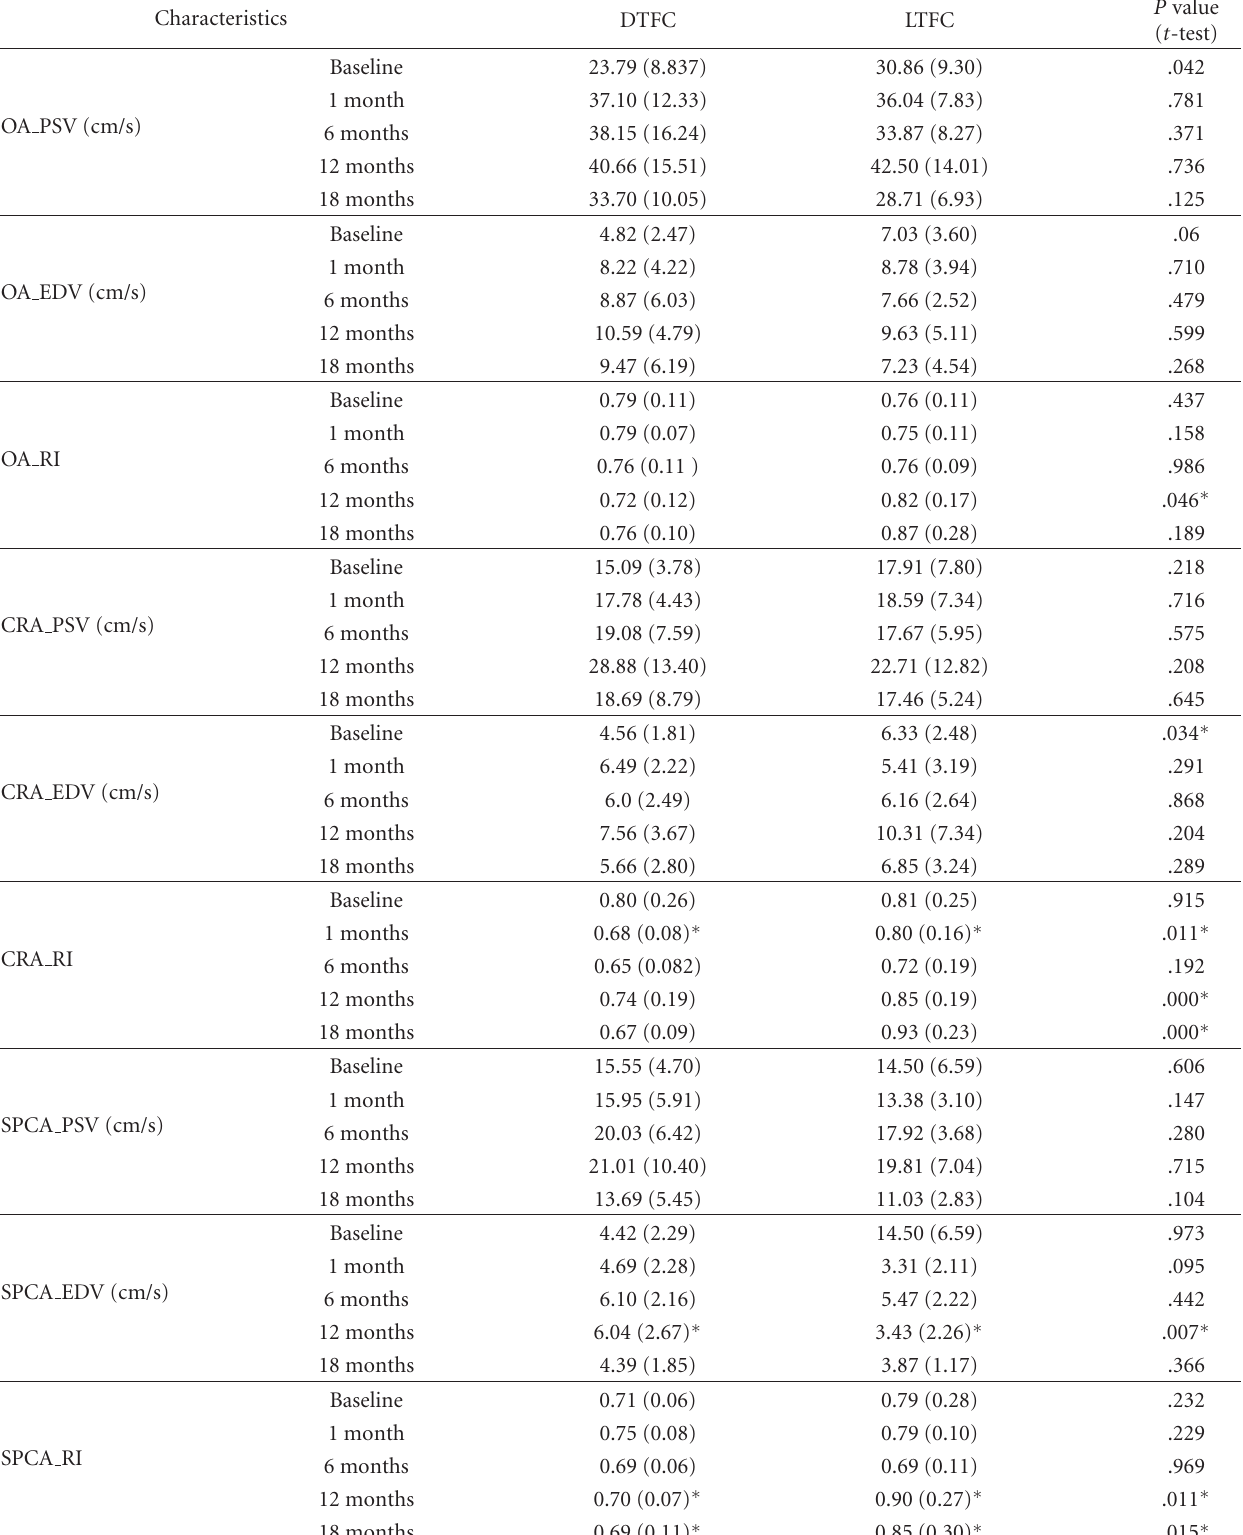
Table 2: Color Doppler imaging parameters during 18 months of